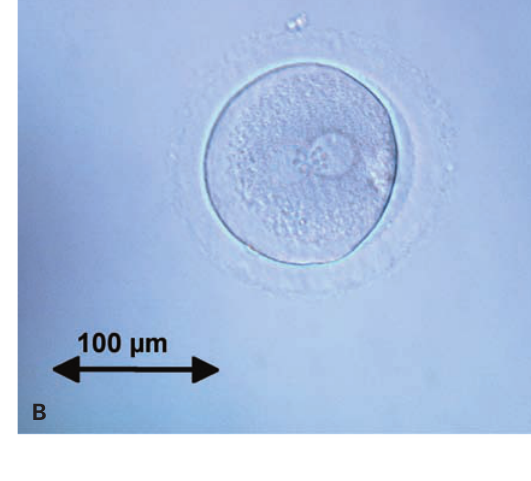
Figure 1 View of the two un - inseminated oocytes (A), which after thaw- ing were treated with ICSI. One of the re- sulting pronucleate oocytes (B) and the two embryos (C) were replaced ap- proximately 48 hours after thawing. One of these embryos led to the pregnancy and delivery, reported in this